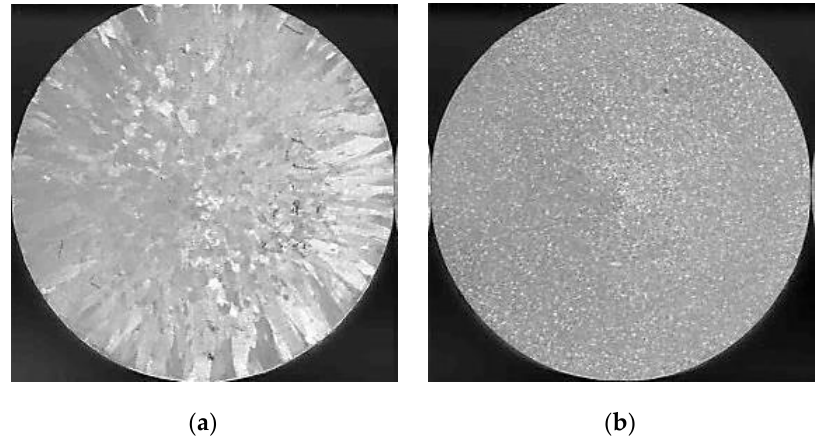
Figure 7. Aluminum alloy ingot macrostructure ( a ) without erbium and ( b ) with erbium.